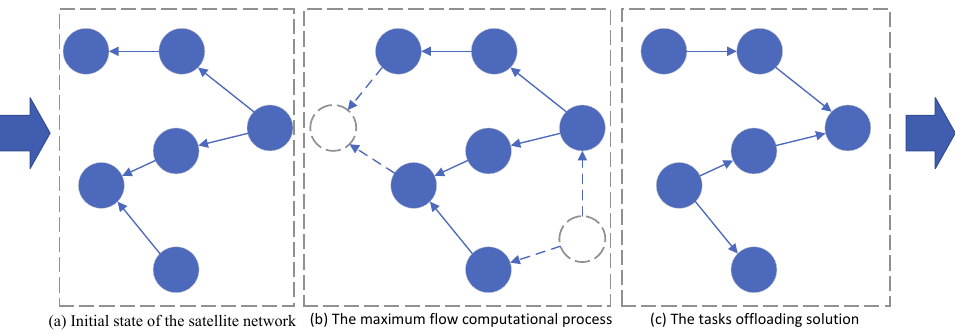
Figure 4. Maximum flow calculation method for task offloading quantity allocation of dynamic satellite